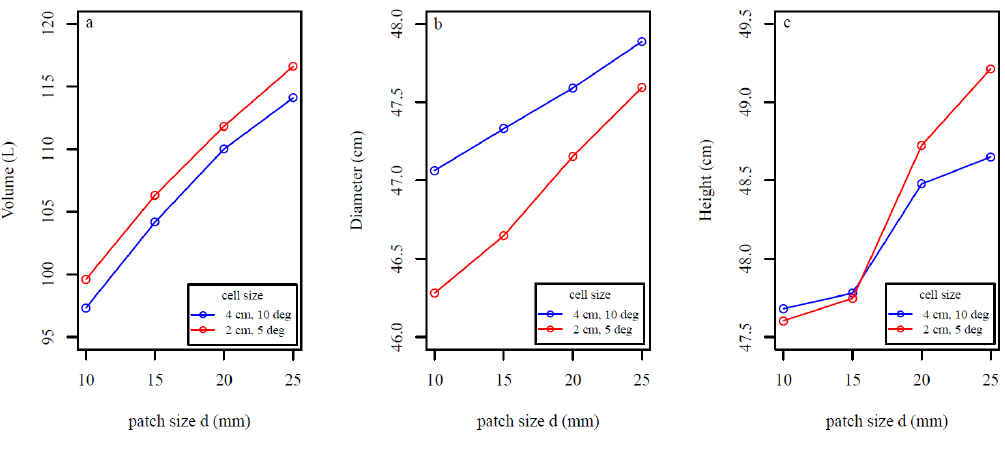
Figure 13. Sensitivity of stump portion ( a ) volume; ( b ) diameter; and ( c ) height to different cover set patch sizes d and cell sizes for 30 model fits of stump 3. Cell size determines the size of the triangles in the cylindrical triangulation model for the stump